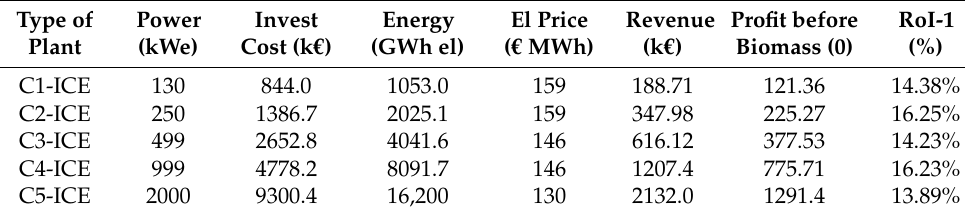
Table 4. Return on investment for selected technologies, plant size and price (Scenario 2).